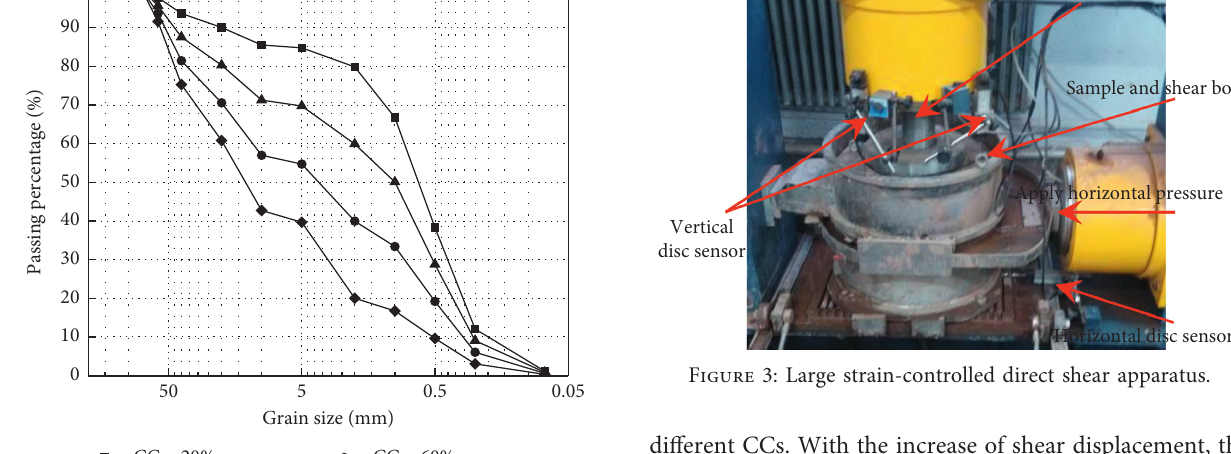
Sample and shear